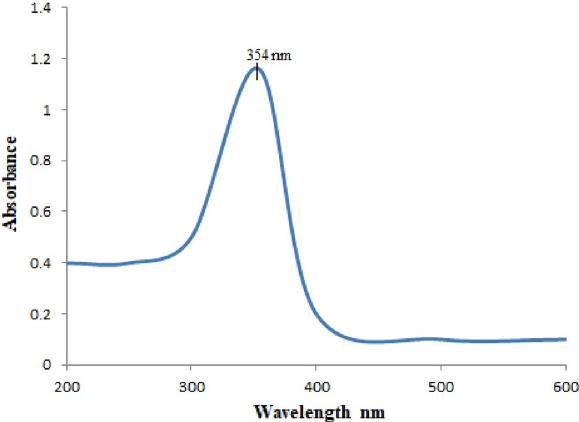
Figure3. Ultra violet visible spectrum of Nigella sativa mediated zinc oxide nanoparticles.